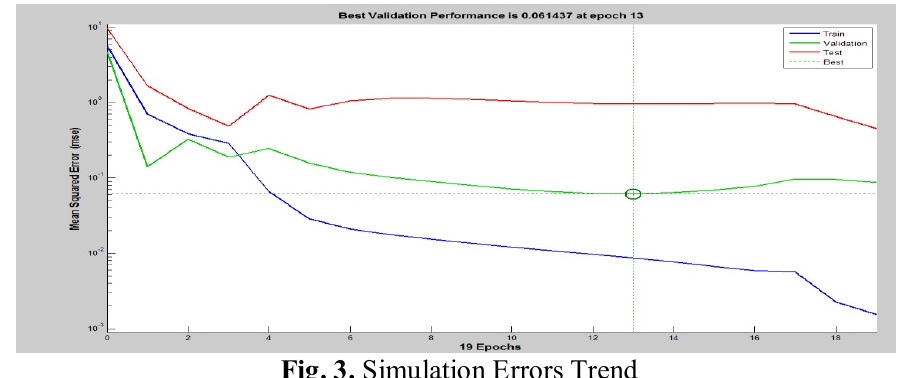
Fig. 3. Simulation Errors Trend